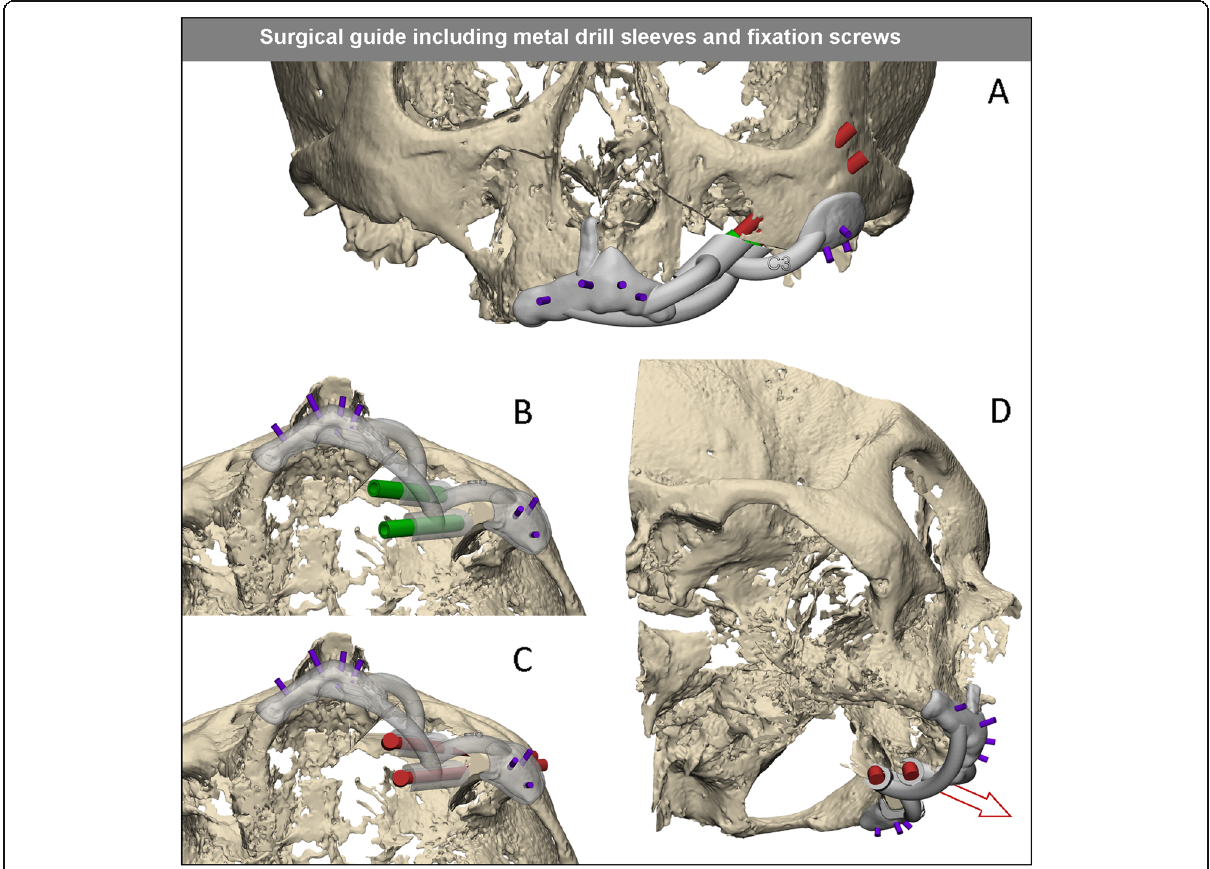
Fig. 3 Detailed view of the guide design. In gray, the body of the 3D printed polyamide guide ( a ). In red, the planned zygomatic implants. In green, the metal inserts used during drilling ( b ). The metal insert is pushed in the guide by the surgeon during surgery. After drilling the trajectory, the metal insert is removed to accommodate the thicker diameter of the implant. The direction as well as the depth of the implant is set by the design and physical dimensions of the guide ( c ). After insertion of the implants, the guide is removed by first removing the mini screws (purple) and then removing the guide in the opposite direction of the slots in the implant guide (red arrow) ( d